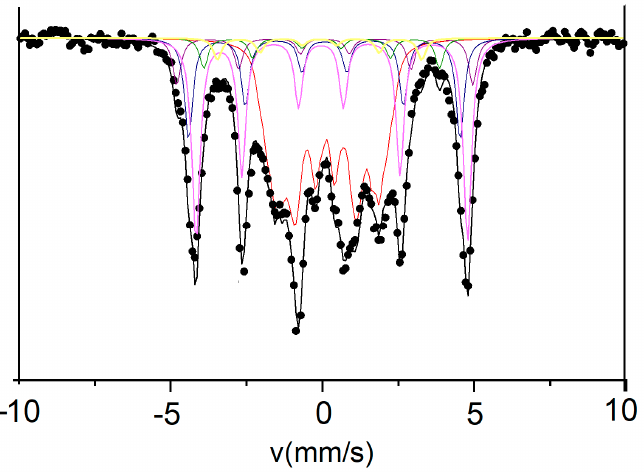
Figure 6. 300 K Mössbauer spectrum of the annealed Fe-Pt-Mo-B sample.